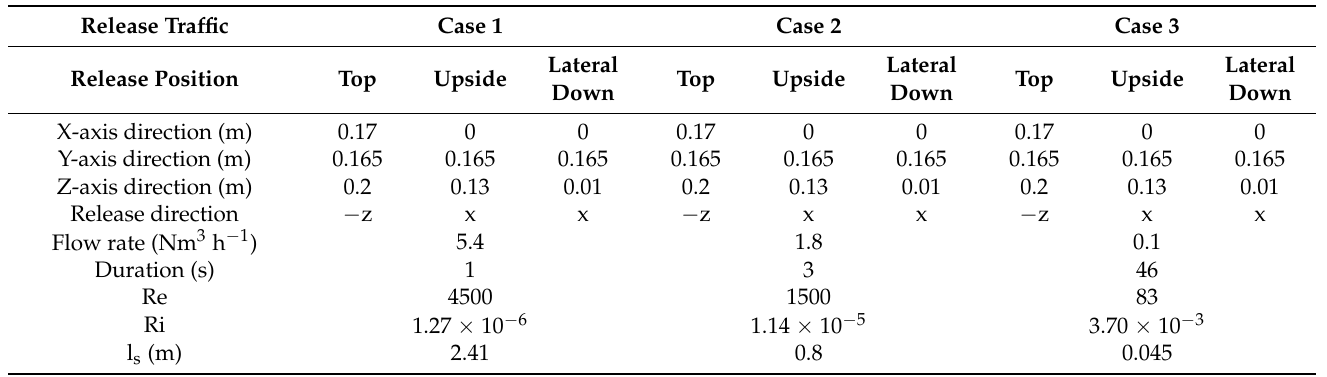
Table 1. Examples of hydrogen diffusion tests in confined spaces.